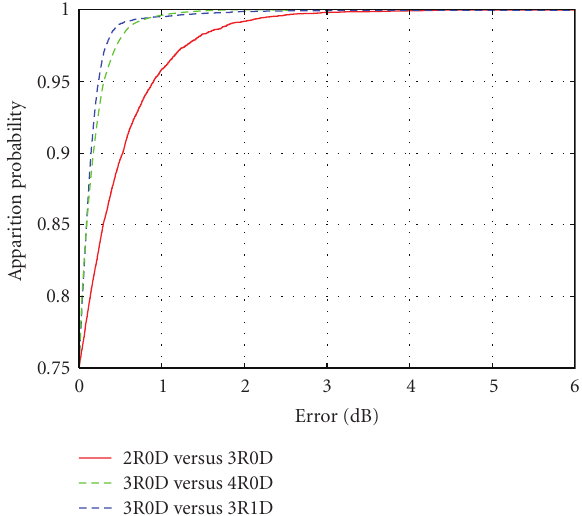
Figure 11: Error cumulative function of estimated received power for di ff erent cases of reflection and di ff